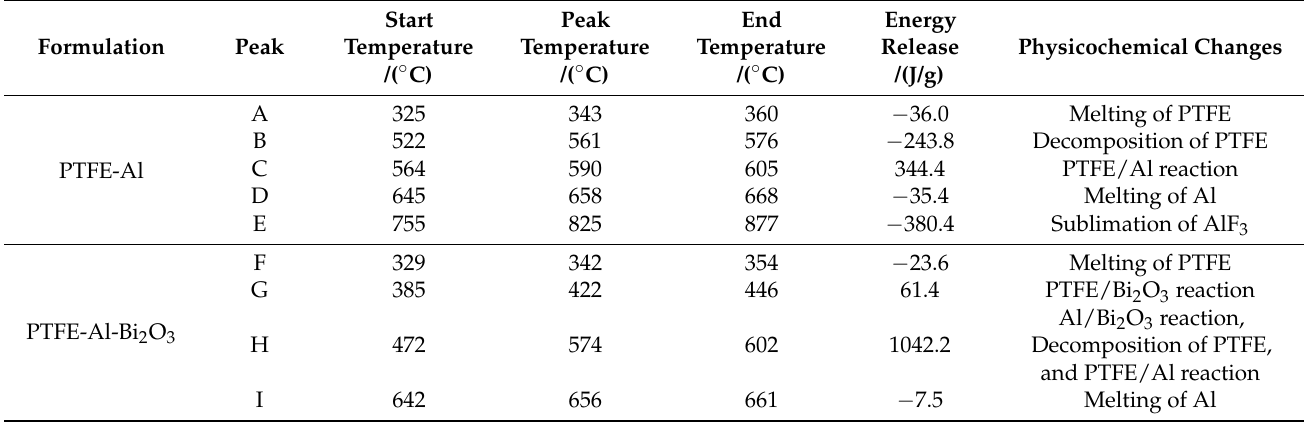
Table 4. Heat absorption and release of peaks in DSC